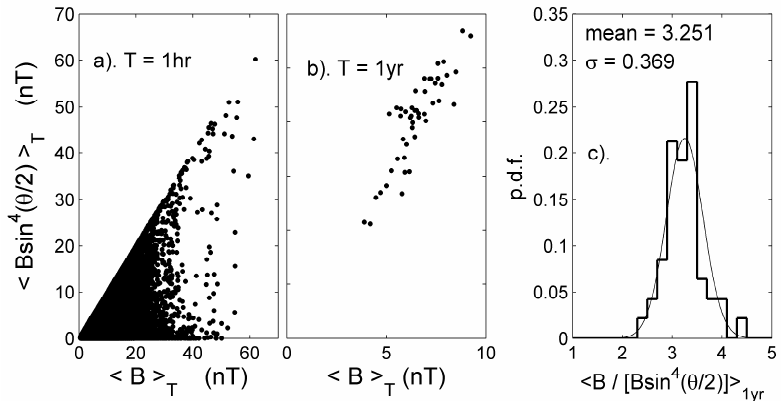
Figure 10: Scatter plots of the half-wave rectified southward component of the IMF in the GSM frame, 𝐵 sin 4 ( 𝜃/ 2) as a function of the IMF magnitude, 𝐵 , for (a) hourly observations and (b) 1-year averages. Panel (c) shows a histogram of the distribution of annual values of the ratio 𝐵/ [ 𝐵 sin 4 ( 𝜃/ 2)], which has a mean value of 3.251 and a standard deviation of 0.369. The thin line is the normal distribution with the same mean and standard